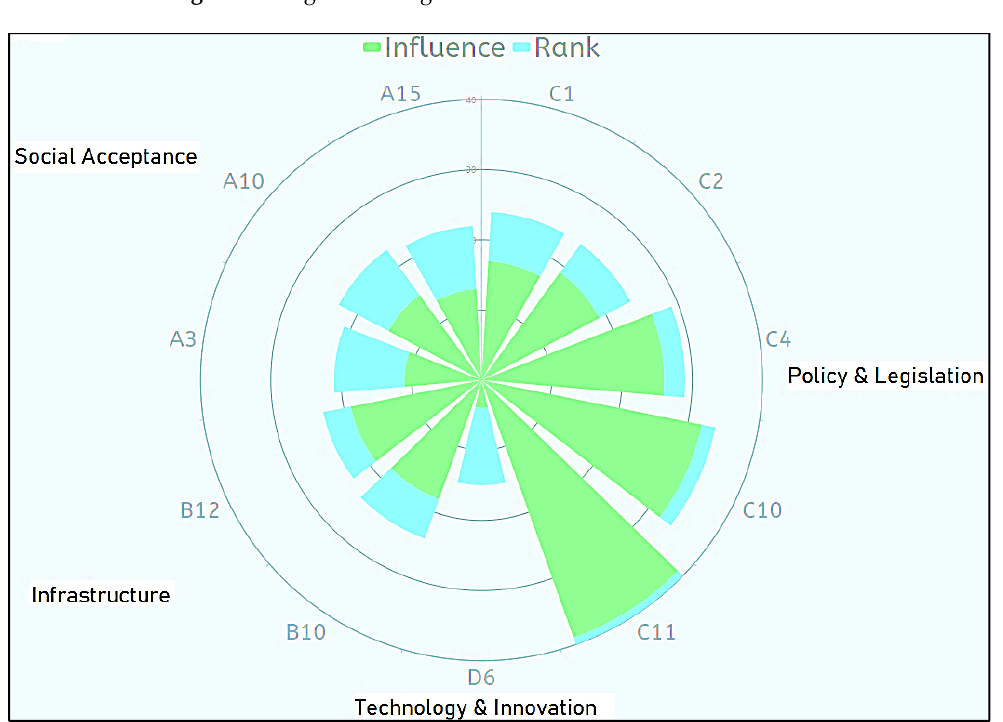
Figure 6. Weighted-in-degree.